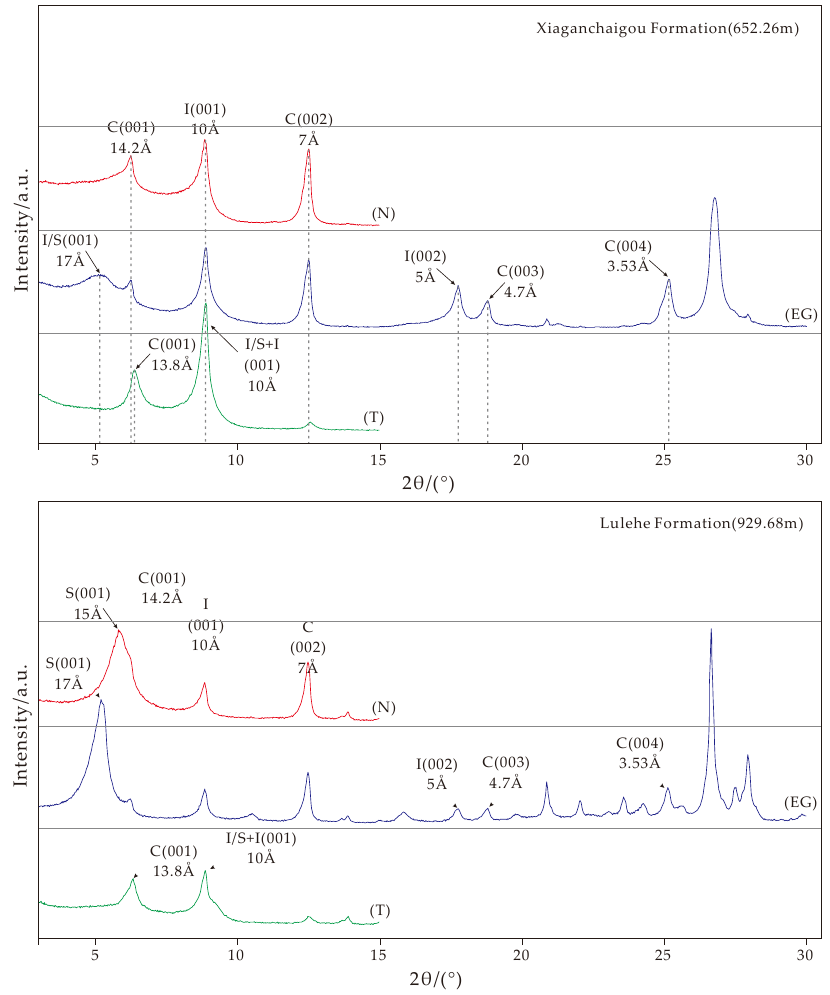
Figure 3. XRD patterns of the representative samples of clay fractions from Well Ping 2 in the Qaidam Basin. S is smectite, I/S is a mixed layer of illite/smectite, I is illite and C is chlorite. N: oriented section; EG: ethylene glycol saturated section; T: heating